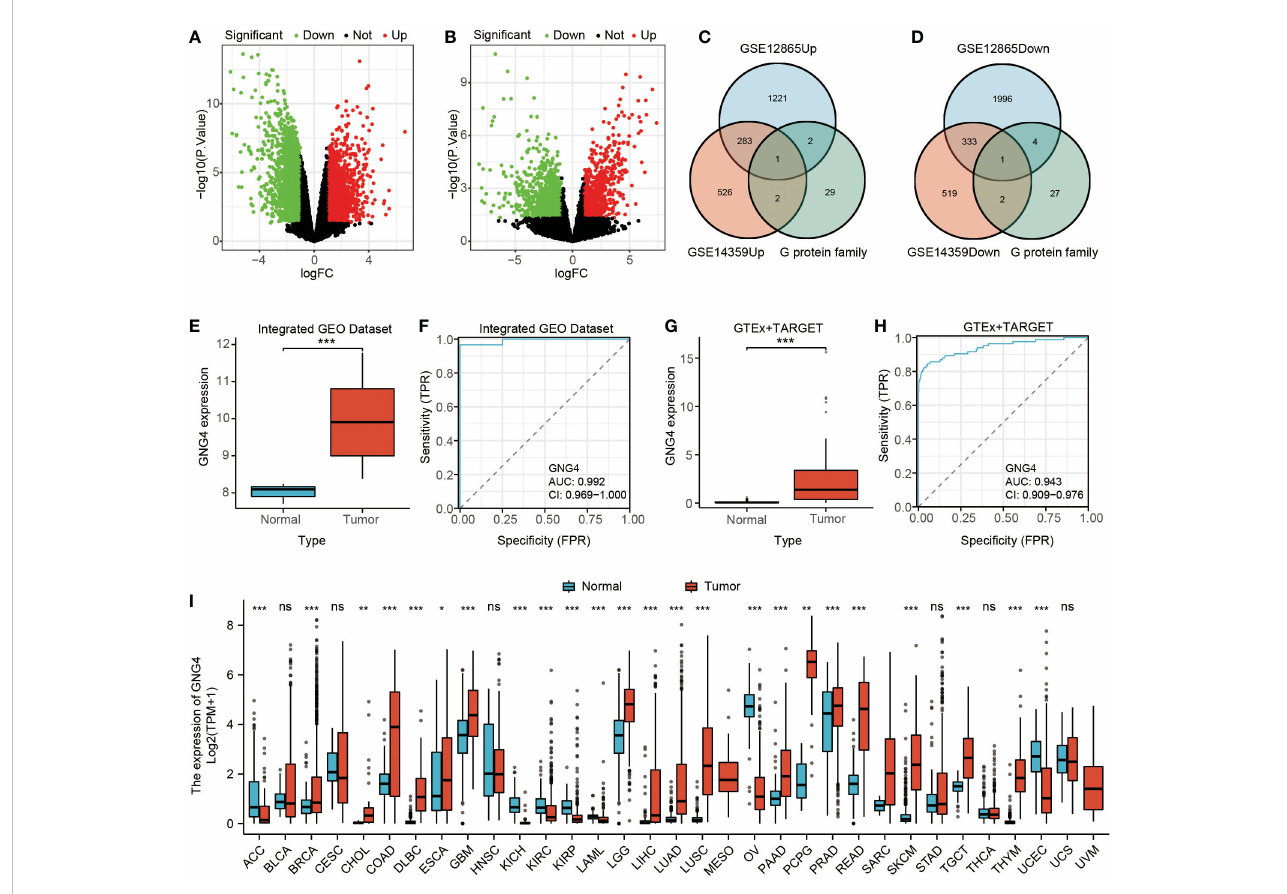
FIGURE 1 Filtered DEGs and GNG4 expression in OS. (A, B) The DEGs between normal and tumour samples of GSE12865 and GSE14359. The signi fi cant differences between the two groups are shown in the form of volcanic maps. (C, D) The G protein family genes were intersected with upregulated and downregulated genes in the two GEO datasets to obtain a Venn diagram of the intersected genes (upregulated GNG4 and downregulated GNG12). (E, G) GNG4 expression in OS in the integrated GEO dataset and GTEx + TARGET dataset, respectively. (F, H) The diagnostic ROC curve of GNG4 in the integrated GEO dataset and GTEx + TARGET dataset, respectively. (I) Differential expression of GNG4 in pancancer tissues. ***p<0.001, **p<0.01, *p ≤ 0.05, and ns,